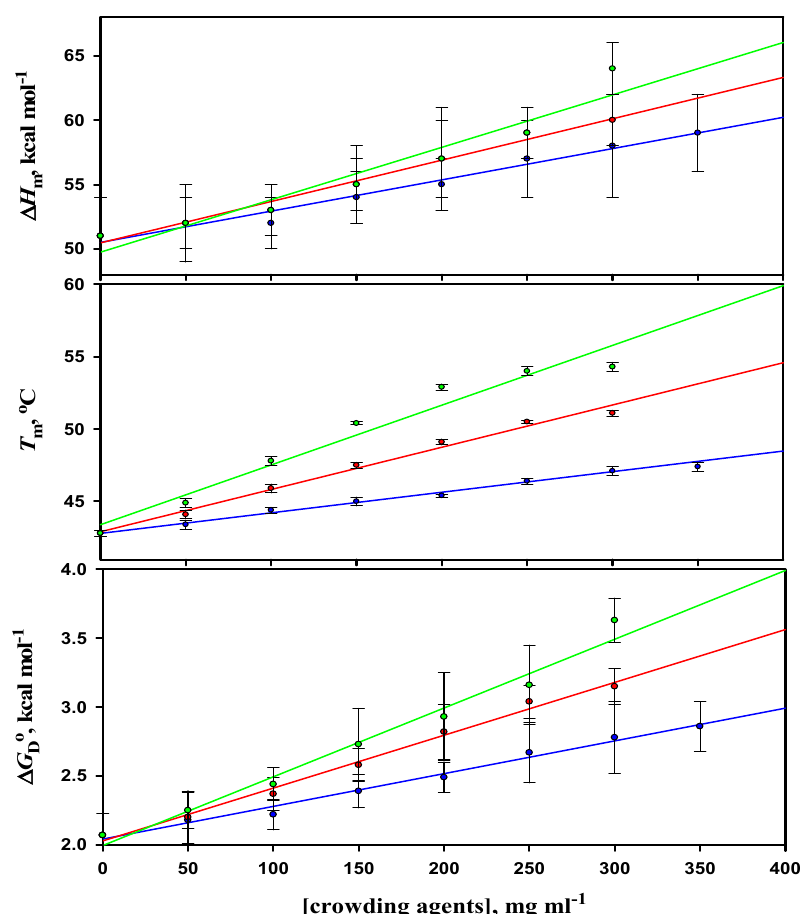
Figure 3. Plots of thermodynamic parameters ( T m , ∆ H m , and ∆ G D ◦ ) associated with the thermal unfolding of α -LA versus the concentration of ficoll 70 (blue line), dextran 70 (red line), and dextran 40 (green line) at pH 7.0.